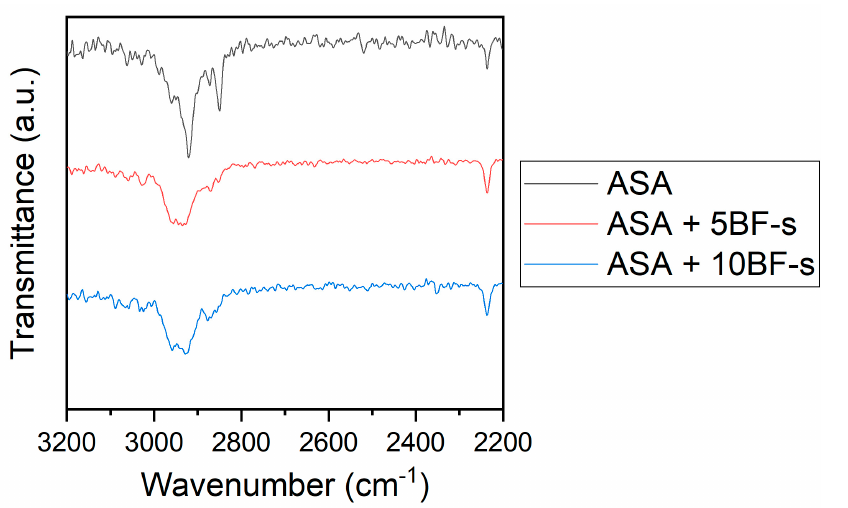
Figure 7. ATR spectra of ASA (black), ASA + 5BF-s (red) and ASA + 10BF-s (blue). Green frame indicates the region of interest.